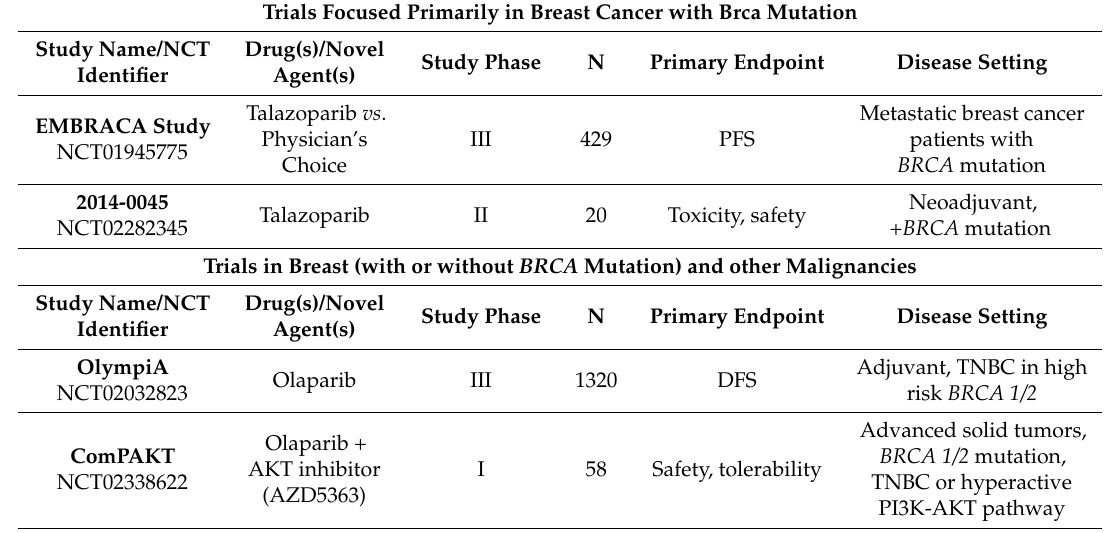
Table 4. Trials of poly (ADP-ribose) polymerase (PARP) inhibitors [16]. Trials Focused Primarily in Breast Cancer with Brca